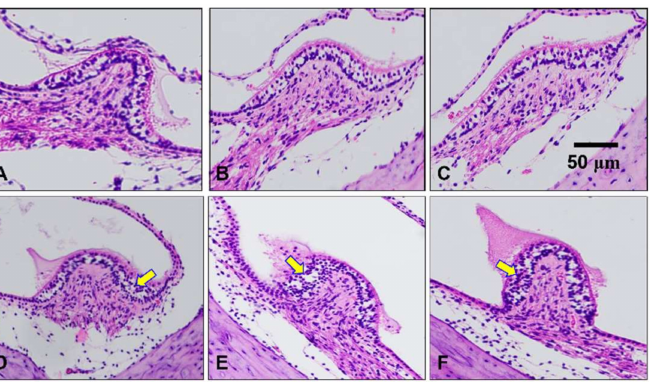
Figure 5. Vestibular crista from shams ( A – C ) and labyrinthectomy model ( D – F ) by FeCl 3 injection. The damaged structures from the chemical injection are indicated by the yellow